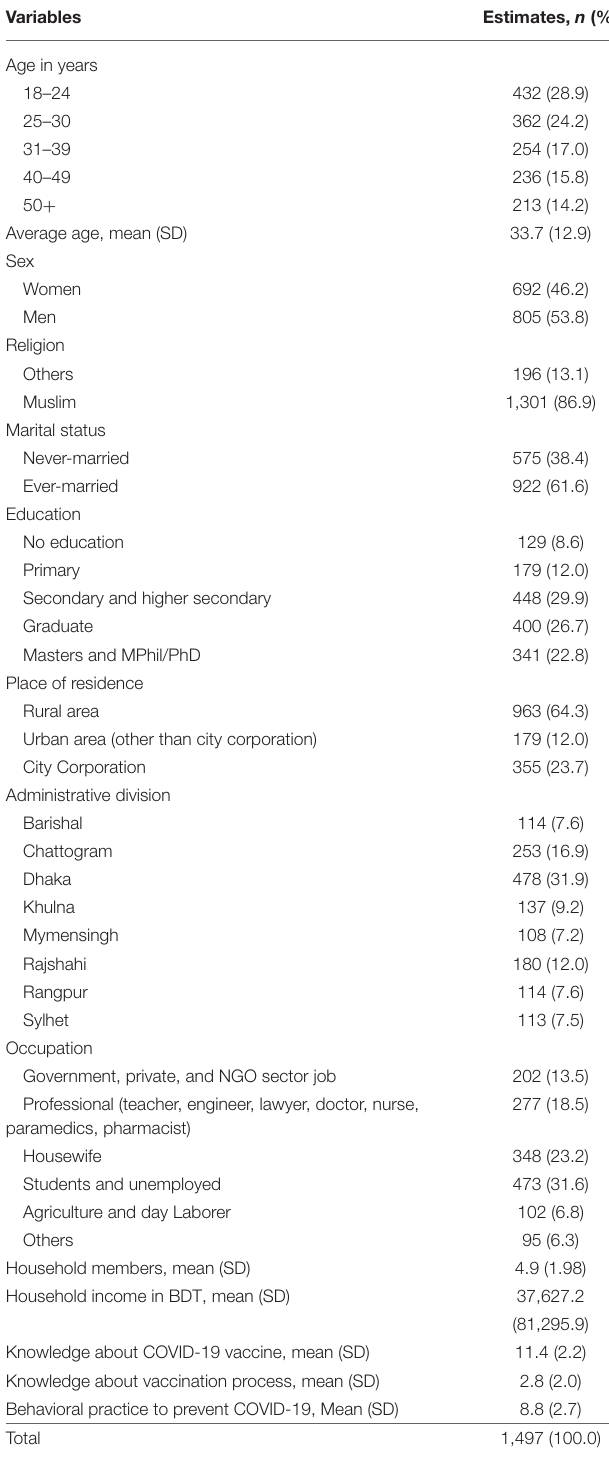
TABLE 2 | Sample characteristics of the